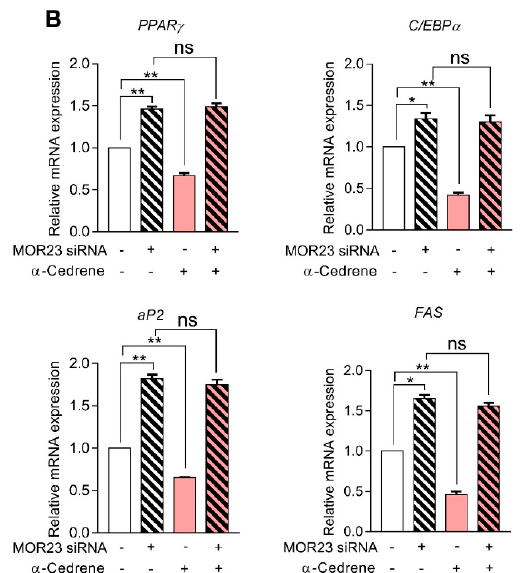
Figure 2. A reduction in MOR23 expression impairs the cAMP signaling pathway and upregulated the mRNA expression of adipogenic genes. 3T3-L1 preadipocytes were transfected with MOR23 siRNA, stimulated to differentiate in culture 2 days after transfection in the presence of 100 µ M α -cedrene or 50:50 ( v / v ) DMSO/acetonitrile (vehicle). Protein and RNA extraction were performed after adipocyte induction. ( A ) Western blot analysis of adenylyl cyclase 3 (ADCY3), PKA C α , and phosphor-AMPK in 3T3-L1 cells transfected with MOR23 siRNA with or without 100 μ M α -cedrene. ( B ) RT-PCR analysis of the mRNA expression of Peroxisome proliferator-activated receptor γ ( PPAR γ ), C/EBP α , aP2 , and FAS in 3T3-L1 cells transfected with MOR23 siRNA with or without 100 µ M α -cedrene. The full-length blots are presented in Supplementary Figure S2. The values represent the means ± SEM, n = 3. Significant differences between groups are indicated by asterisks; * p < 0.05; ** p < 0.01; ns, not significant ( p > 0.05).